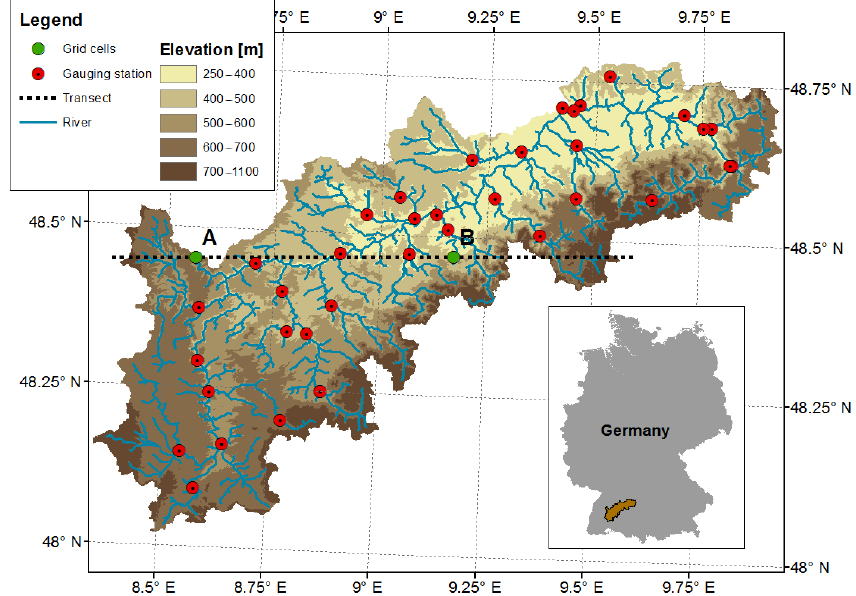
Figure 2. Location of the upper Neckar catchment within Germany. The positions of the 36 gauging stations (red points) used for defining the subcatchments, the transect (dashed black line) and the two grid cells analysed (green points A and B) are depicted on the map.